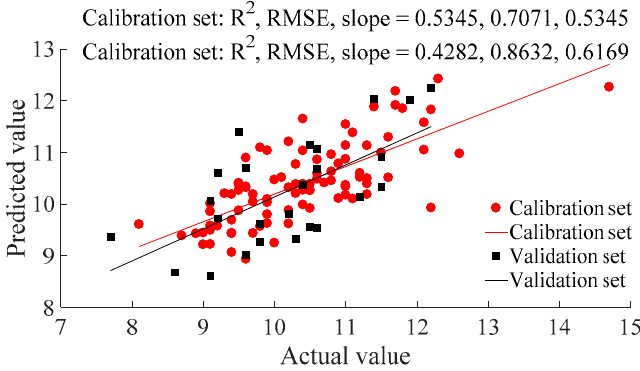
Figure 6. PLSR detection results of TSS based on E-nose with combined feature extraction method.